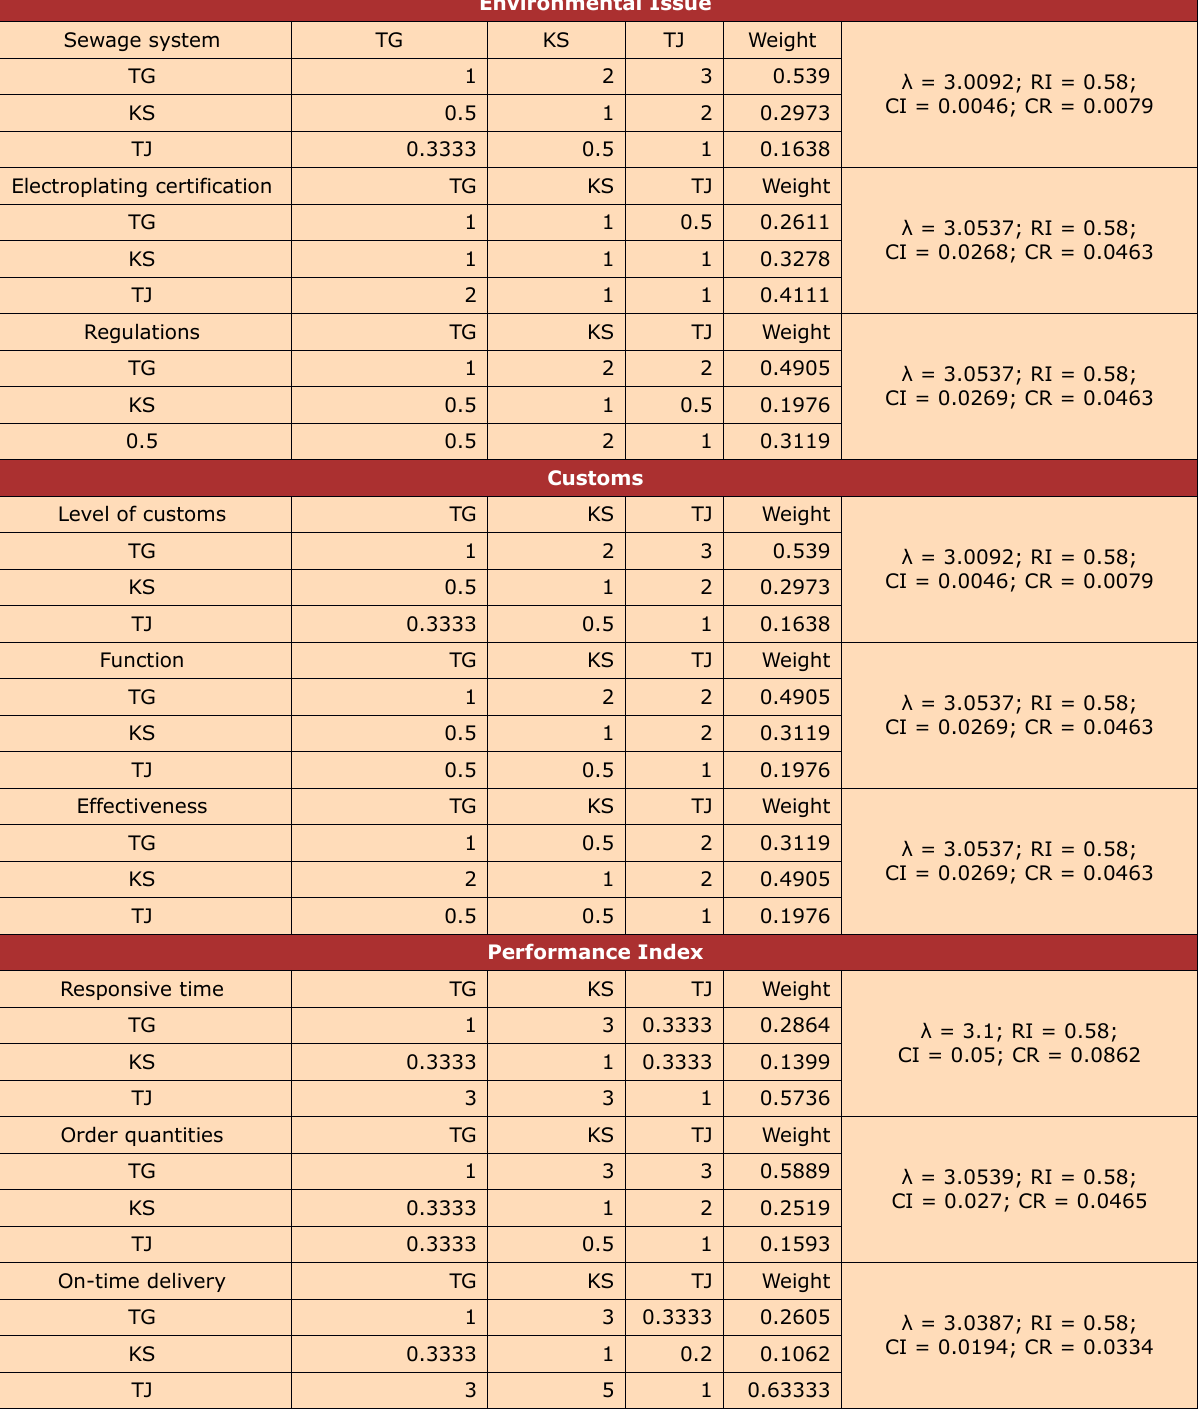
Table 6. Pair-wise comparison matrix among alternatives for subcriteria under cost, workforces, and supply